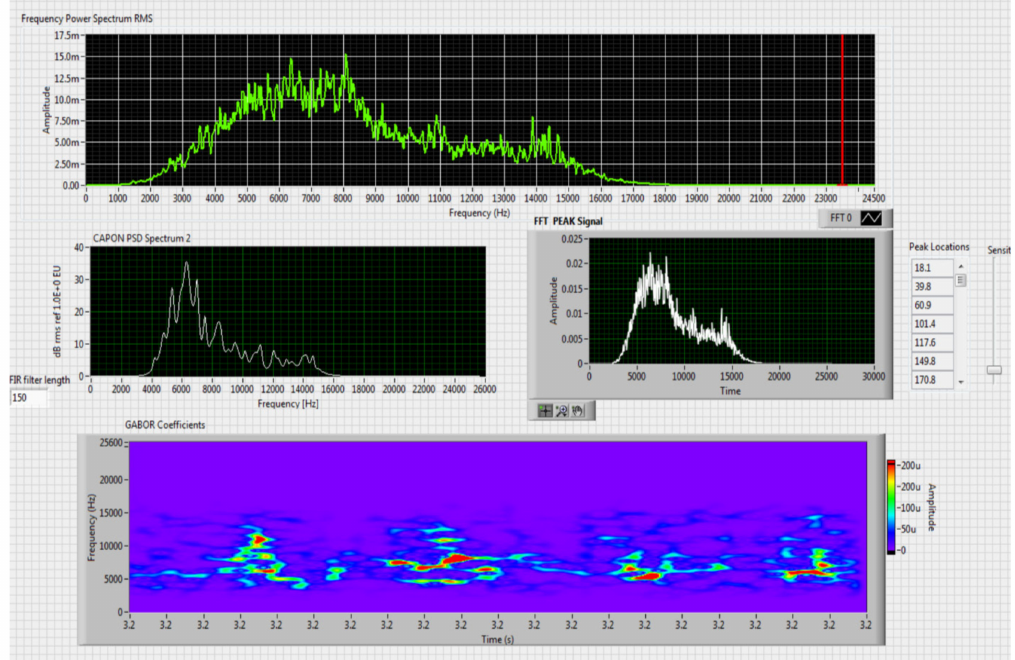
Figure 12. Results obtained for stationary distance 150 m, altitude 4